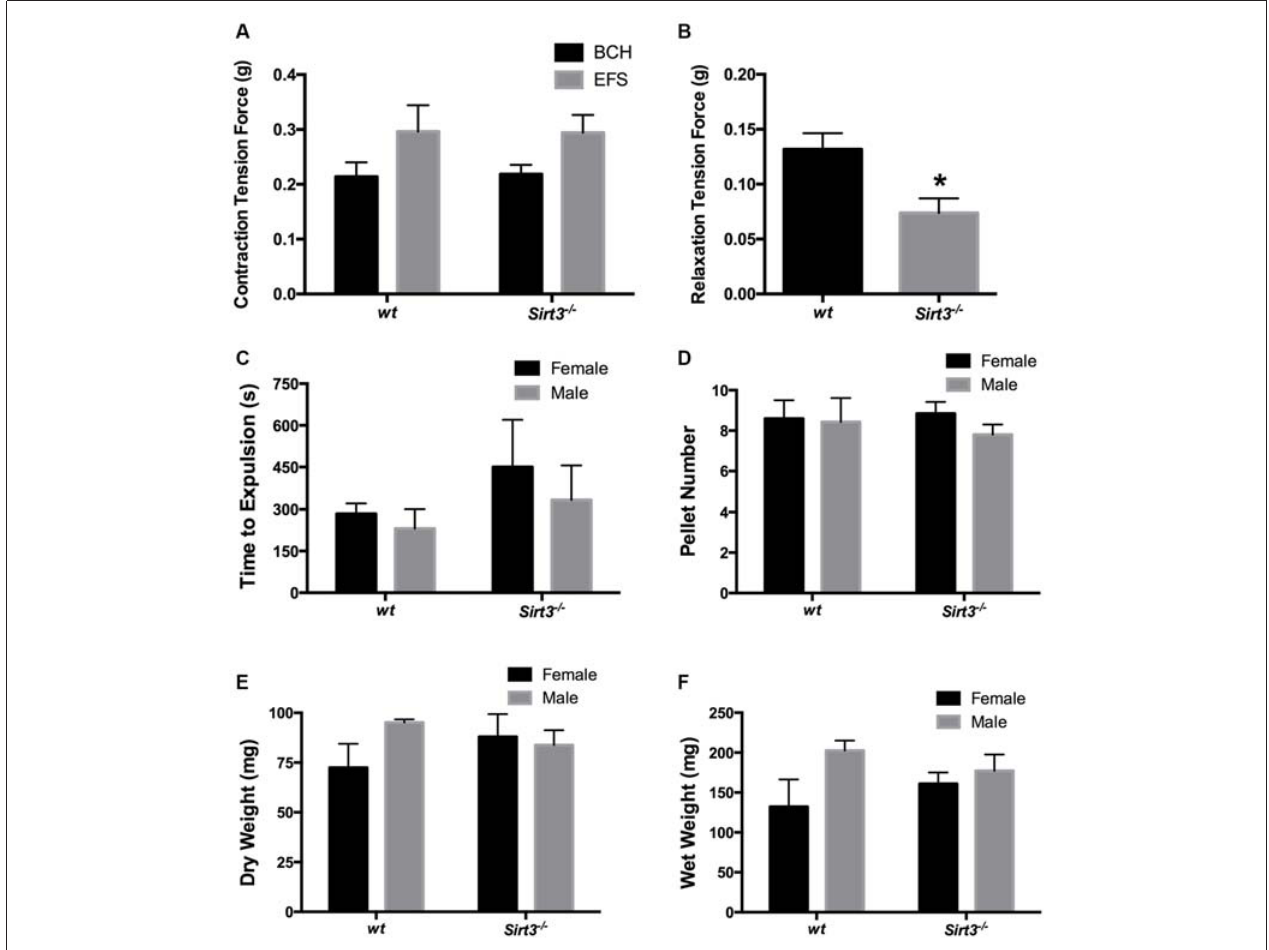
FIGURE 3 | Effect of the ablation of Sirt3 on gut function in healthy animals. (A) Contractile responses of longitudinal segments of colon driven by bethanechol (BCH, 10 µ M) or electrical field stimulation (EFS) are similar in mice with wild type Sirt3 ( wt ) and Sirt3 null mice ( Sirt3 − / − ; n = 5 animals per group, P > 0.05, Student’s t -test). (B) Relaxations driven by EFS (at 20 Hz) in pre-contracted (PGF 2 α , 5 µ M) longitudinally-oriented segments of colon from Sirt3 − / − mice and their respective wt controls. EFS produced significantly smaller relaxations in tissues from Sirt3 − / − mice than wt controls ( n = 5 animals per group, ∗ P =